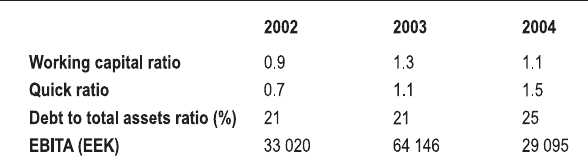
Fig. 5. General fi nancial fi gures of NERH,